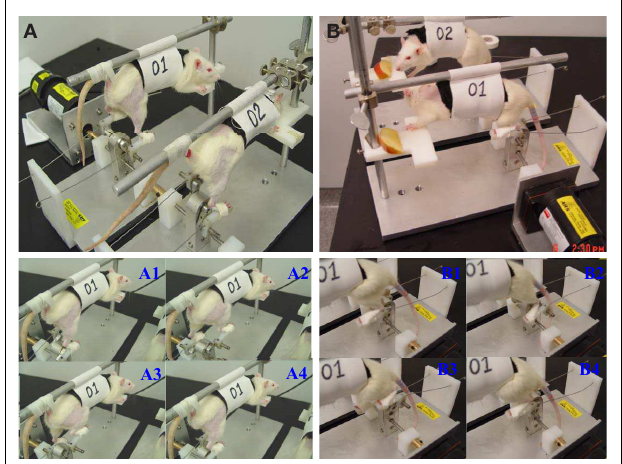
FIGURE 1 |A custom made motorized rat bicycle (A,B), and a series of sequential video images of spinal cord-contused rats cycling on this apparatus. Note, right hindlimb was shaved for EMG recording. During the first week of training, the tail was taped (A,A1–A4) to provide maximum body support. However, the body support was gradually reduced to maximize the loading during training after first week (B, B1–B4)